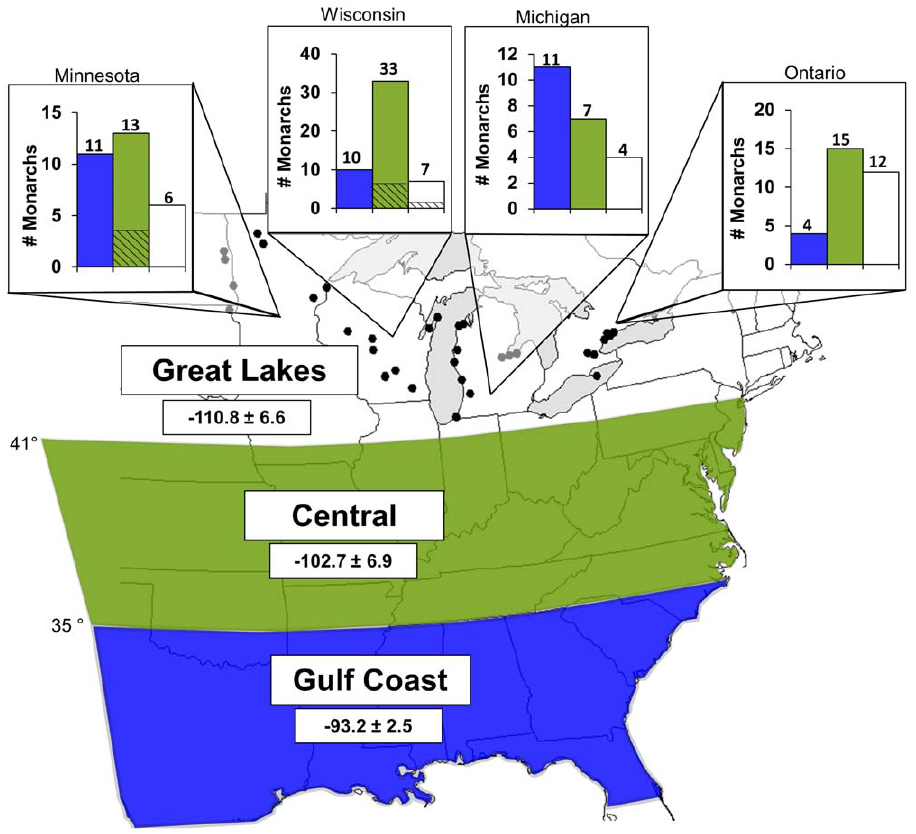
Figure 1. The estimated natal origin of monarchs captured in the Great Lakes region. Bar graphs (number above each bar shows sample size) indicating the number of monarchs originating from one of three breeding regions: Gulf Coast (blue), Central (green), and the Great Lakes (white). Bar graphs are arranged according to the state/province where monarchs were sampled (black dots indicate sampling locations). Bars with cross-hatching represent the proportion of monarchs estimated to have followed a SS strategy, all others are SB (blue and green non-hatched) or the offspring of SS/SB monarchs (white bars). Numbers within each breeding region are the mean 6 SD stable-hydrogen isotope ( d D) values calculated from precipitation and adjusted according to a fixed discrimination factor (see methods for details on assignment tests).